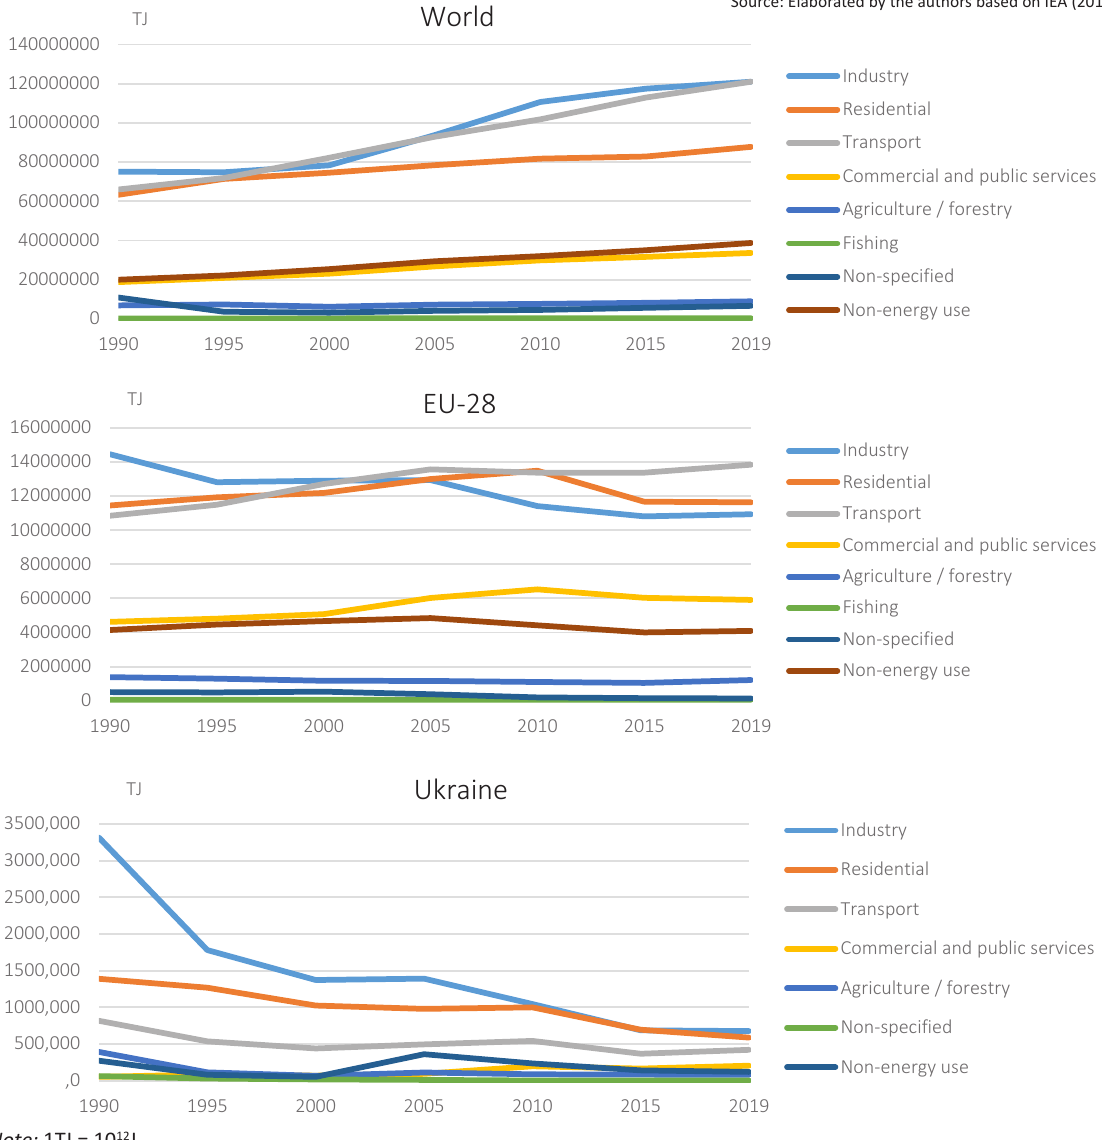
Figure 4. Total final energy consumption by sector in the world, European Union-2 8 and Ukraine in 1990–2019,